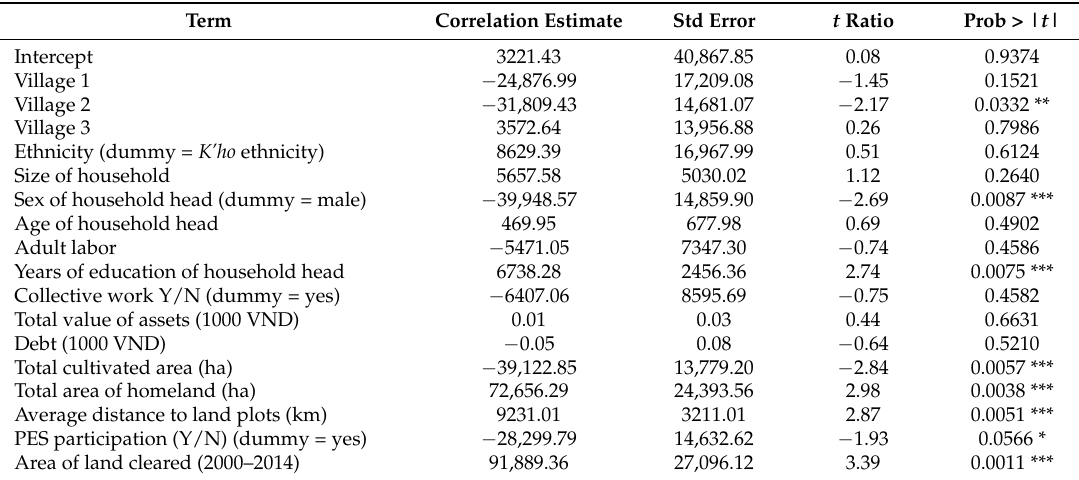
Table 2. Total income by socio-economic assets, Dha Nhim and Da Chais communes, Lam Dong Province, Vietnam, 2014 ( N =